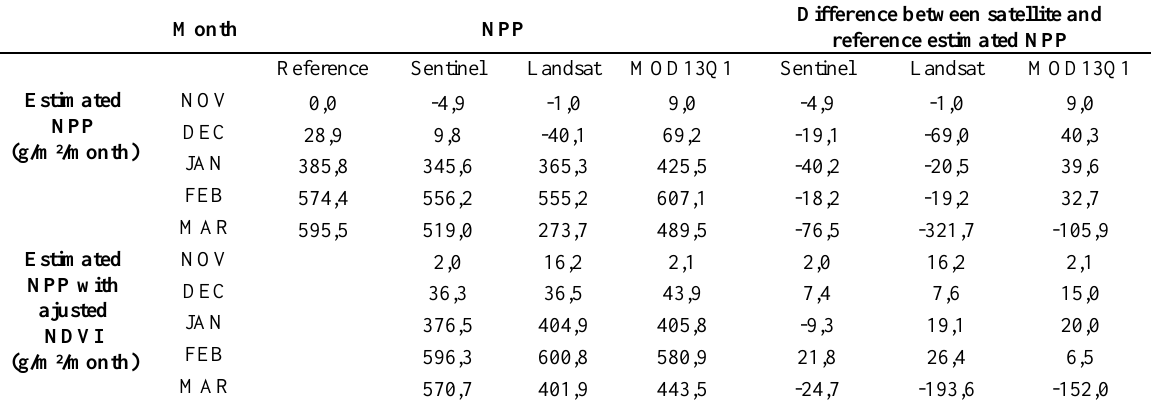
Table 2. Net Primary Productivity (NPP) of soybeans estimated using Normalized Difference Vegetation Index (NDVI) data obtained from different sensors and estimated NPP from NDVI adjusted data through equations. Carazinho/RS,